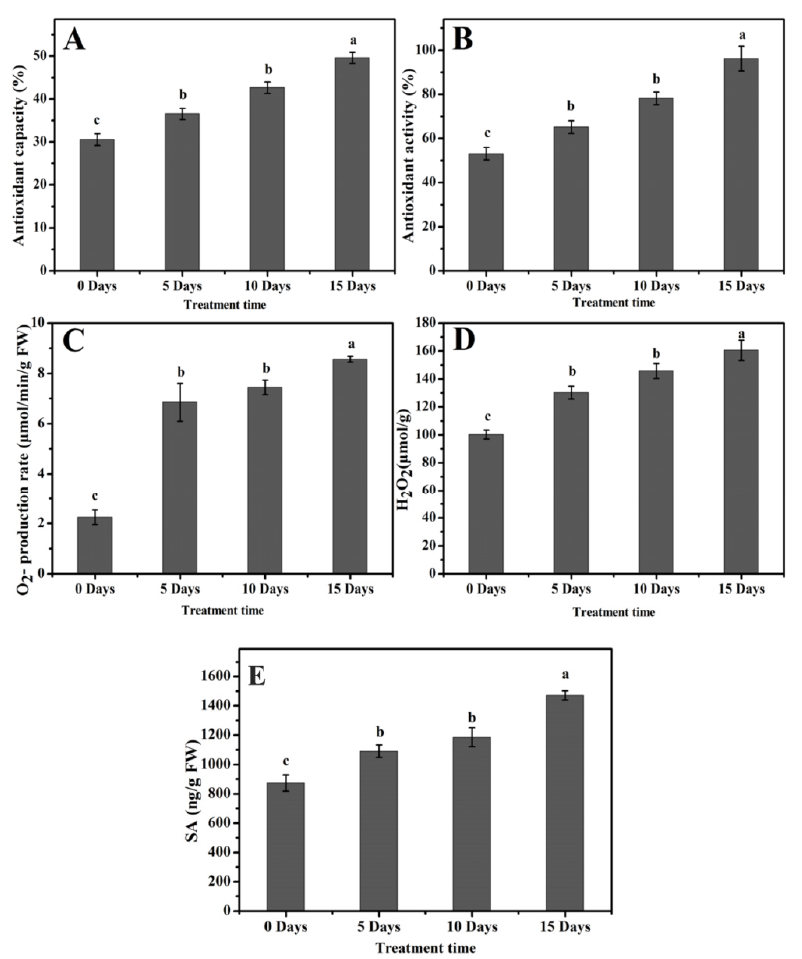
Figure 6. Antioxidant, reactive oxygen species, and salicylic acid response to drought stress in Populus leaves under drought stress. ( A ) Antioxidant capacity, ( B ) Antioxidant activity, ( C ) O 2 – production rate, ( D ) H 2 O 2 production, ( E ) Salicylic acid. The values are presented as means ± standard error (SE) ( n = 3). The different small letters indicate a significant difference ( p < 0.05) among different treatments.